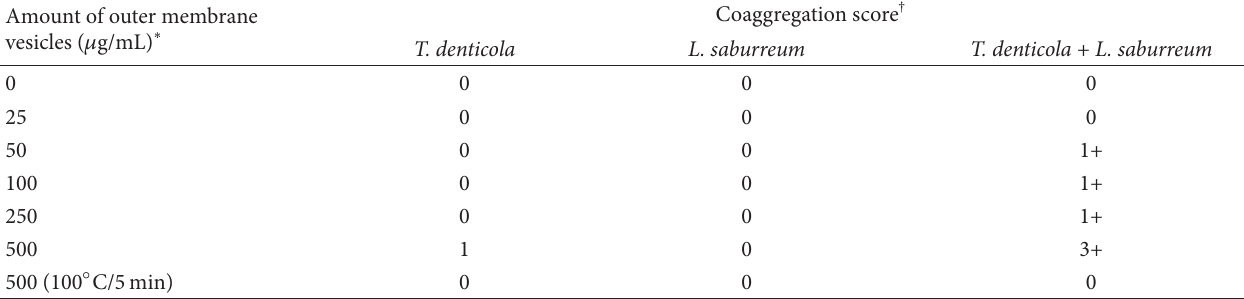
T 1: P. gingivalis outer membrane vesicle-induced coaggregation between T. denticola and L. saburreum . Amount of outer membrane